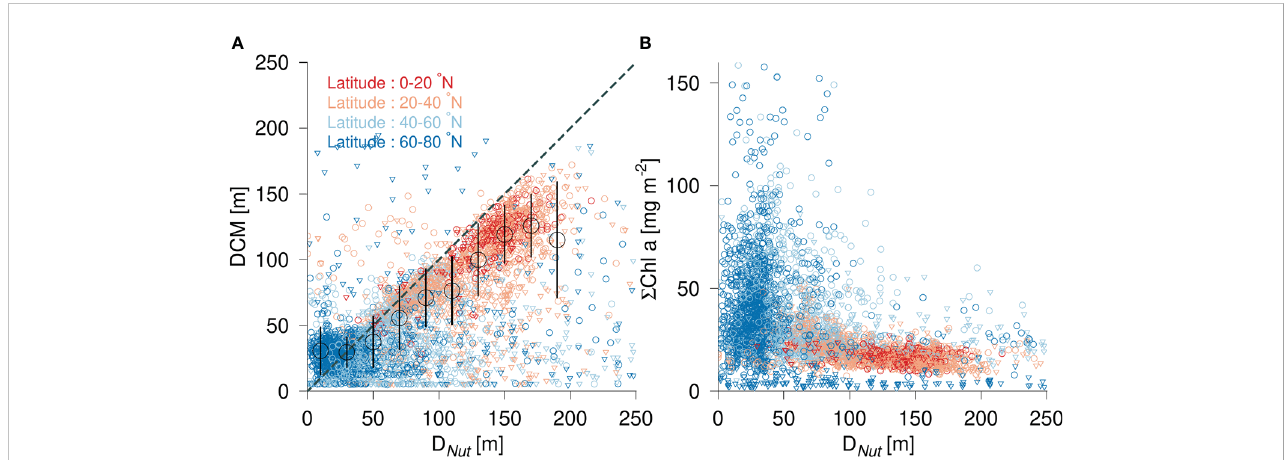
FIGURE 2 (A) Depth of the deep chlorophyll a maximum (DCM) versus nutricline depth (D Nut ) and binned average values during the growth season (April-October, black circles ± std. dev.). (B) Vertically integrated chlorophyll ( S Chl) versus D Nut . Color shading shows the latitude of the corresponding pro fi le. Observations are shown during the growth season (April-October, circles) and during winter time (November-March,